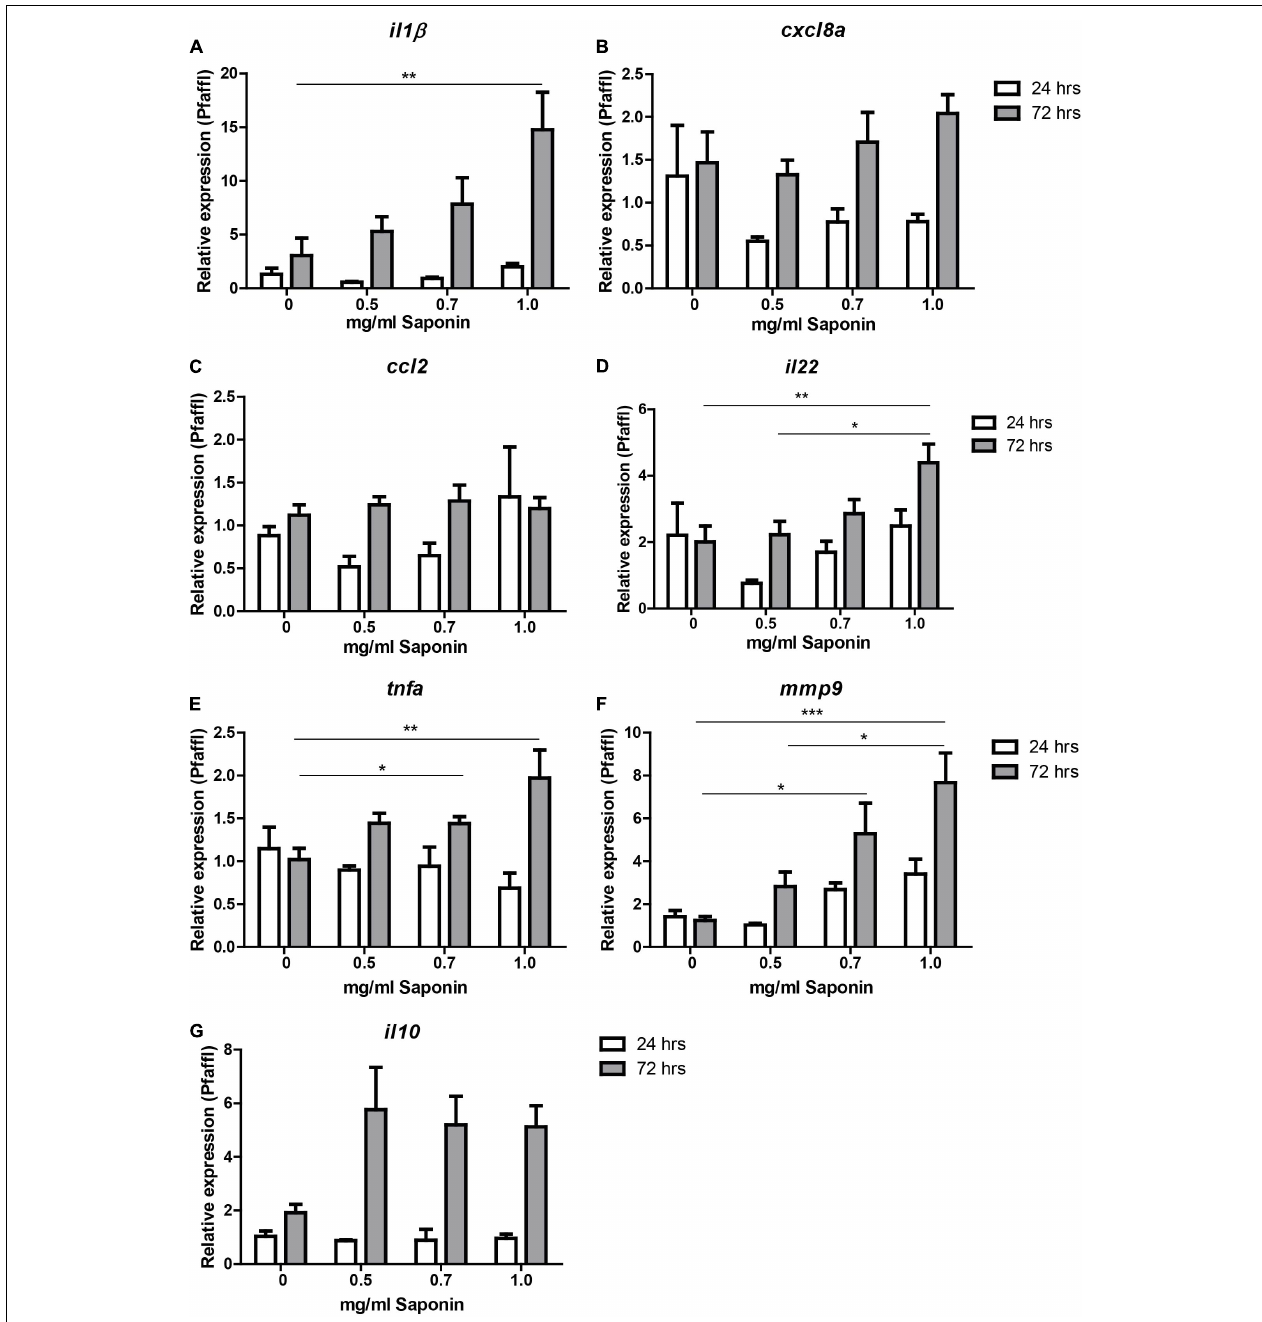
FIGURE 3 | Relative gene expression of saponin-treated zebrafish. Zebrafish were immersed in different doses of saponin (0, 0.5, 0.7 and 1 mg/ml, from 6 to 9 dpf). At 24 h (7 dpf) and 72 h (9 dpf) zebrafish larvae were euthanized and 5 whole zebrafish were pooled for each sample. After RNA extraction and cDNA synthesis, qPCR was performed for the following cytokines: (A) il-1 β , (B) cxcl8a, (C) ccl2, (D) il22, (E) tnfa (tnf α 2), (F) mmp9, and (G) il10. Three pools of five larvae were used per group at 24 h, and 7–9 pools of five larvae per group at 72 h. Data were tested for normality with Kolmogorov-Smirnov. Non-parametric analysis was performed by one way ANOVA Kruskal-Wallis test with Dunn’s Multiple comparison post-test for il1b and mmp9. Parametric analysis was performed by one way ANOVA with Tukey post hoc for il22, and tnfa . Results are displayed as mean ± SEM. Two independent experiments were performed and the data were combined.